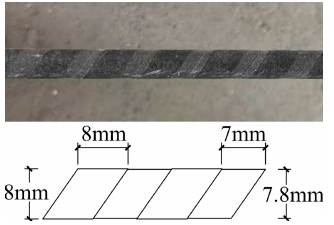
Figure 4. Basalt Fiber-Reinforced Polymer (BFRP) bar used in the study.